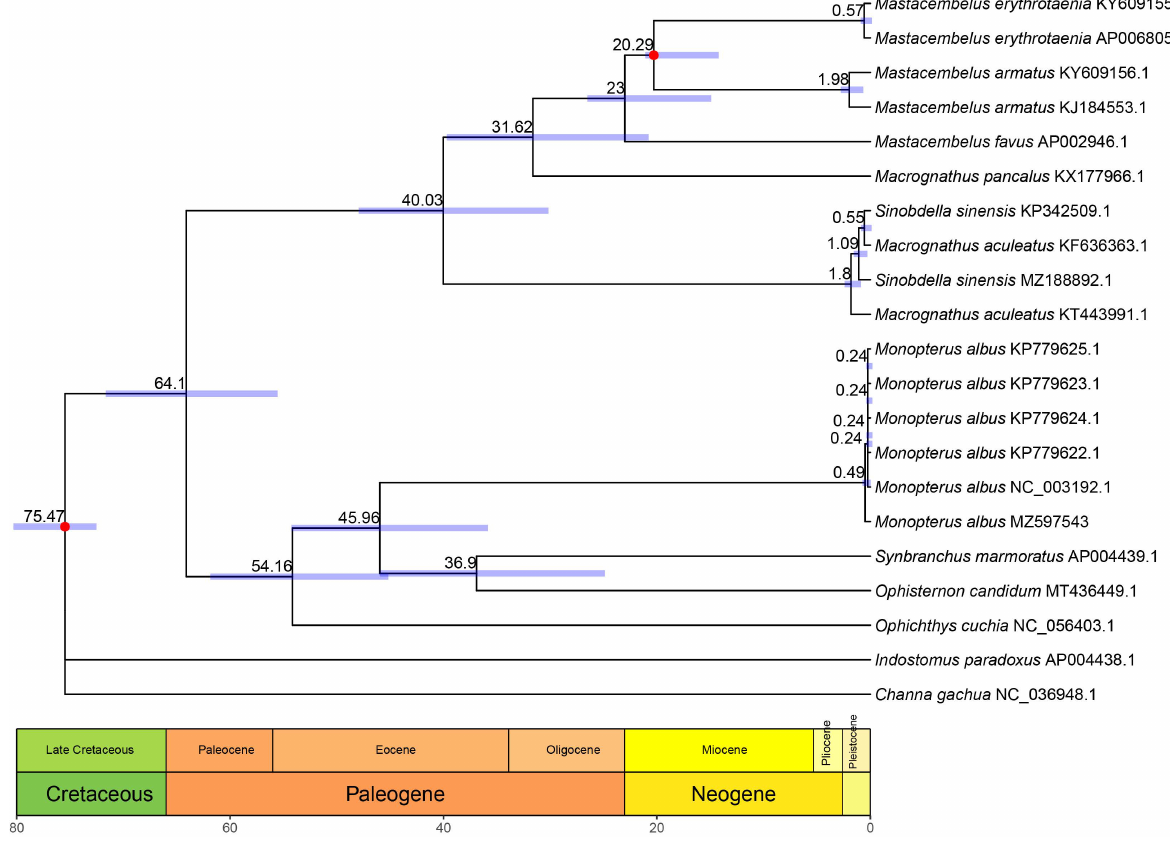
Figure 4. The evolutionary timeline of the order Synbranchiformes was estimated using RelTime based on the 13 concate- nated PCGs. Numbers on the scale bar are millions of years before the present. Light blue bars on nodes represent 95% confidence intervals. The red dot denotes the calibration time point. Geologic timescale is shown at the bottom of the